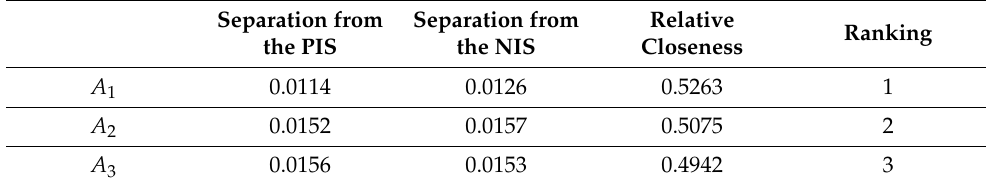
Table 8. Ranking of each alternative.